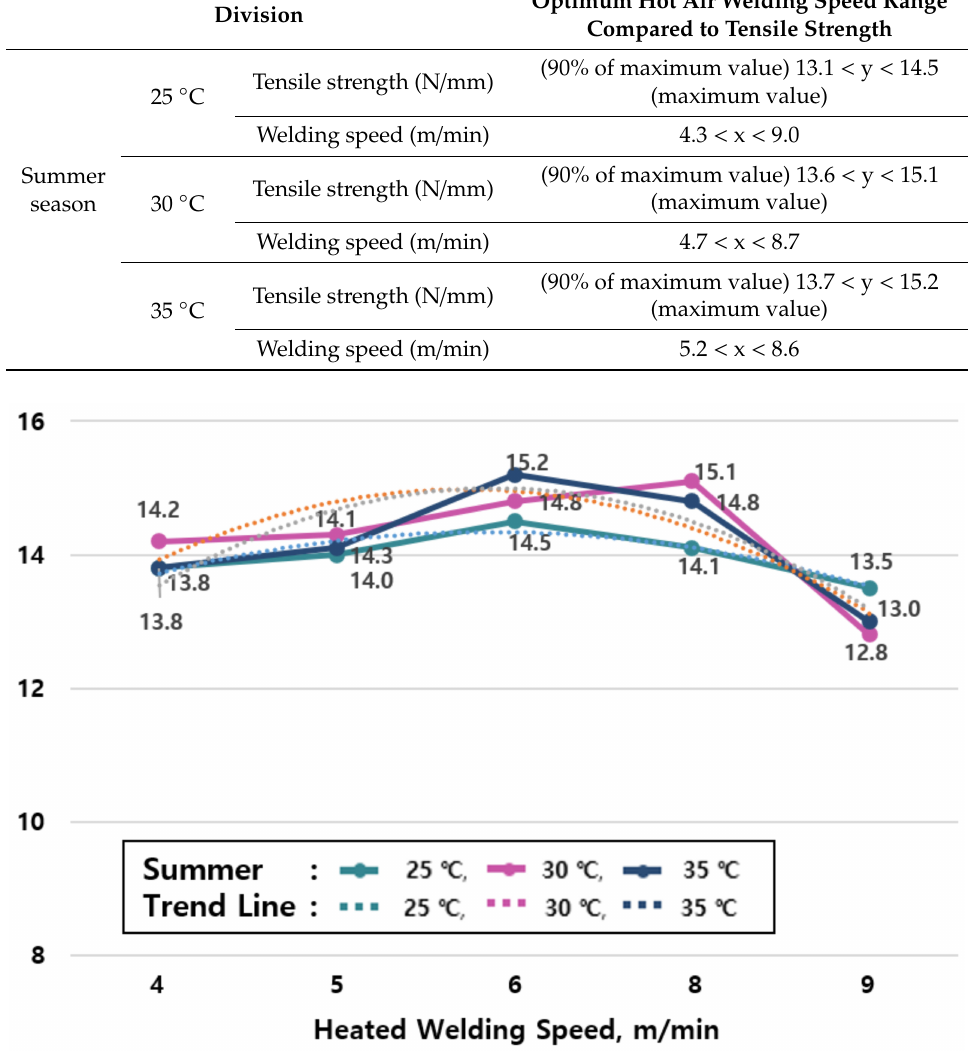
Figure 9. Analysis of the optimum hot air welding speed by temperature in